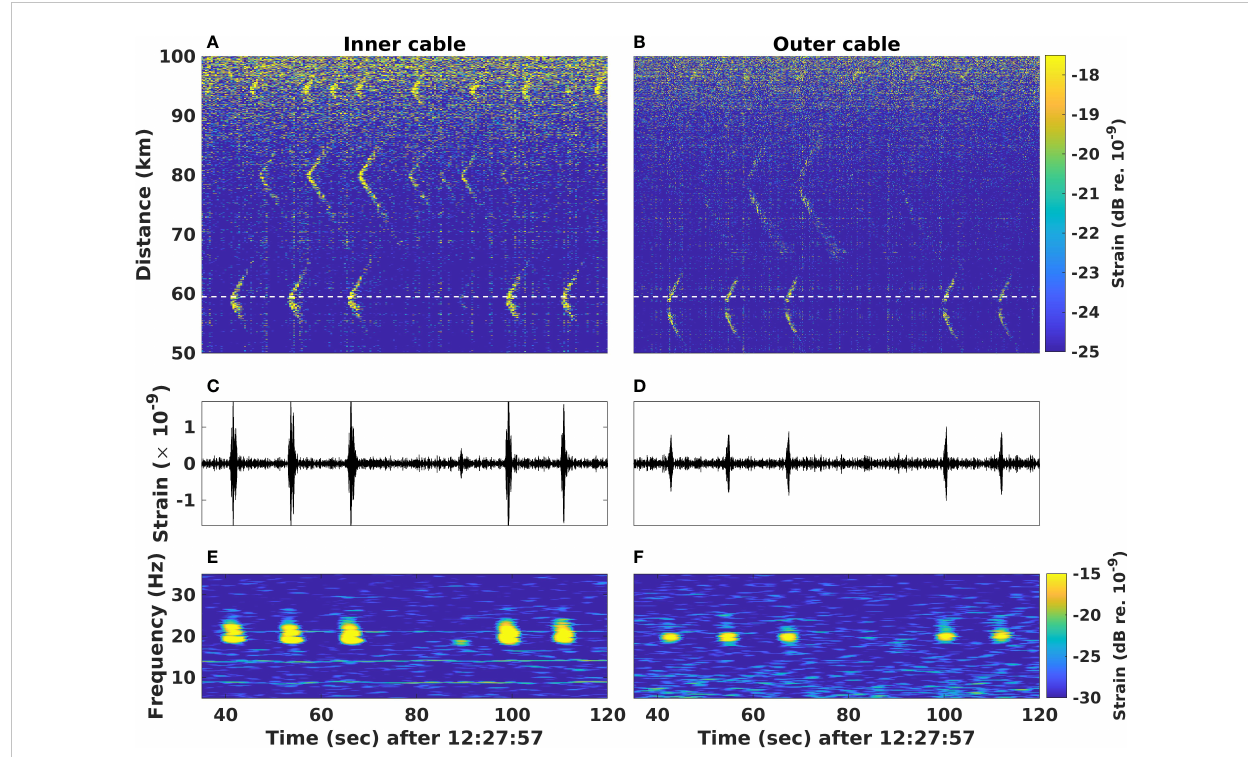
FIGURE 3 Distributed acoustic sensing recording of fi n whale vocalizations on two fi ber-optic cables on 2022.08.22 at 12:27:57 UTC. (A, B) Spatio-temporal ( t − x ) representation of three simultaneously vocalizing whales on the inner cable (A) and the outer cable (B) between 50 and 100 km. Waveforms (C, D) and corresponding spectrograms ( t − f ; E, F) at 59.52 km, represented by the white dashed line in (A, B), displaying portions of two series of fi n whale 20 Hz calls and a back-beat at ≃ 95 is recorded on both cables with an average inter-call interval of 13 s. The spectrograms were computed using a Hann window of 512 samples with 98%